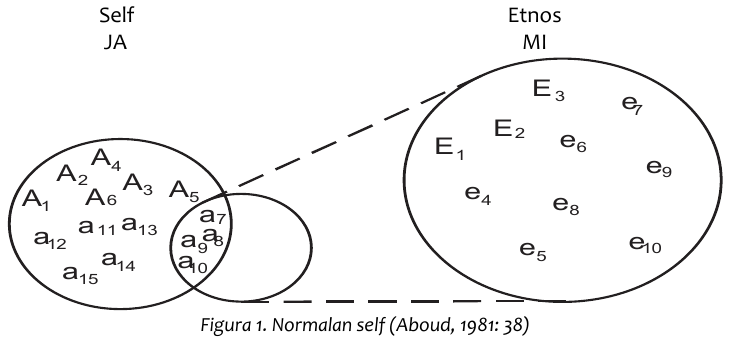
Figura 1. Normalan self (Aboud, 1981: